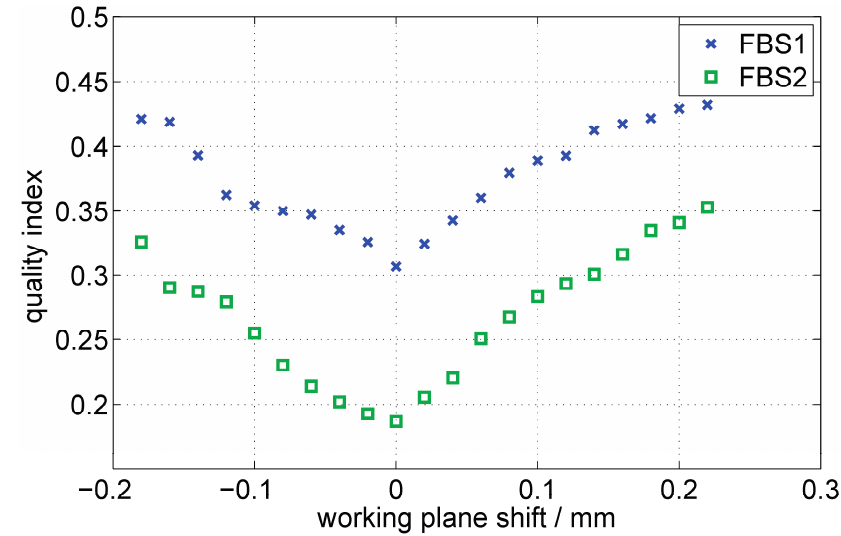
Figure 5. The behavior of the quality index for the deviation from the focal position for FBS-1 and FBS-2.